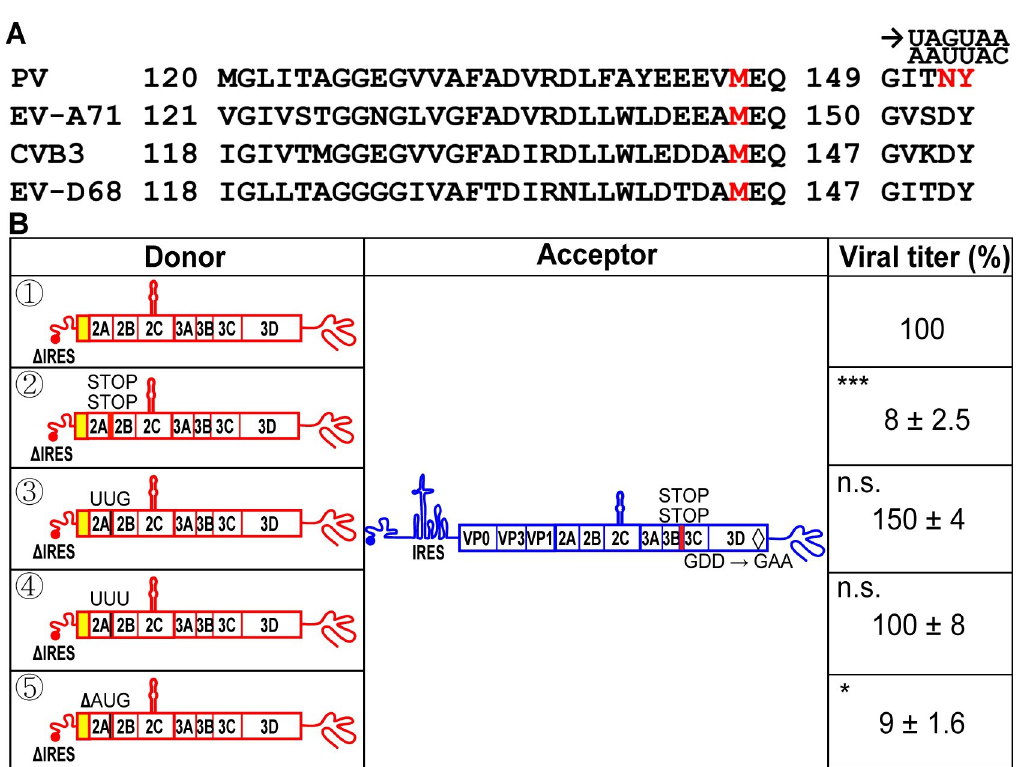
Fig 9. Deletion of a conserved AUG in the 2A-coding sequence reduces translation of the donor RNA leading to a reduction in viral RNA recombinants. (A) Primary amino acid sequence alignment of a portion of 2A sequence from PV, EV-A71, CVB3, and EV-D68. Numbers refer to 2A protein sequence. The conserved methionine is shown in red. The sites for the insertion of two STOP codons are shown in red; the codons AAU and UAC were changed to UAG and UAA, respectively. (B) Comparison of infectious virus produced by the indicated donor RNAs with the specified modifications: ① : Δ IRES; ② : Insertion of two STOP codons after the 2A-coding sequence (2A STOP); ③ : AUG to UUG; ④ : AUG to UUU; ⑤ : Δ AUG. Sites for the modifications are depicted. In all cases, the acceptor RNA contained two STOP codons after 3B-coding sequence (3B STOP) and the mutation that inactivates the RdRp (GDD to GAA). Indicated are the relative viral titers with the average viral titer from recombination using Δ IRES donor ( ① ) and acceptor set as 100% (7,500 pfu/mL, mean ± SEM; n = 3). Statistical analyses were performed using unpaired, two-tailed t test ( � indicates p < 0.05, ��� indicates p < 0.001, n.s. indicates not significant). The 2A STOP and Δ AUG reduced viral recombinants, while the AUG to UUG and AUG to UUU did not. Numerical data provided as Supporting information (S1 Data). IRES, internal ribosome entry site; PV, poliovirus; RdRp, RNA- dependent RNA